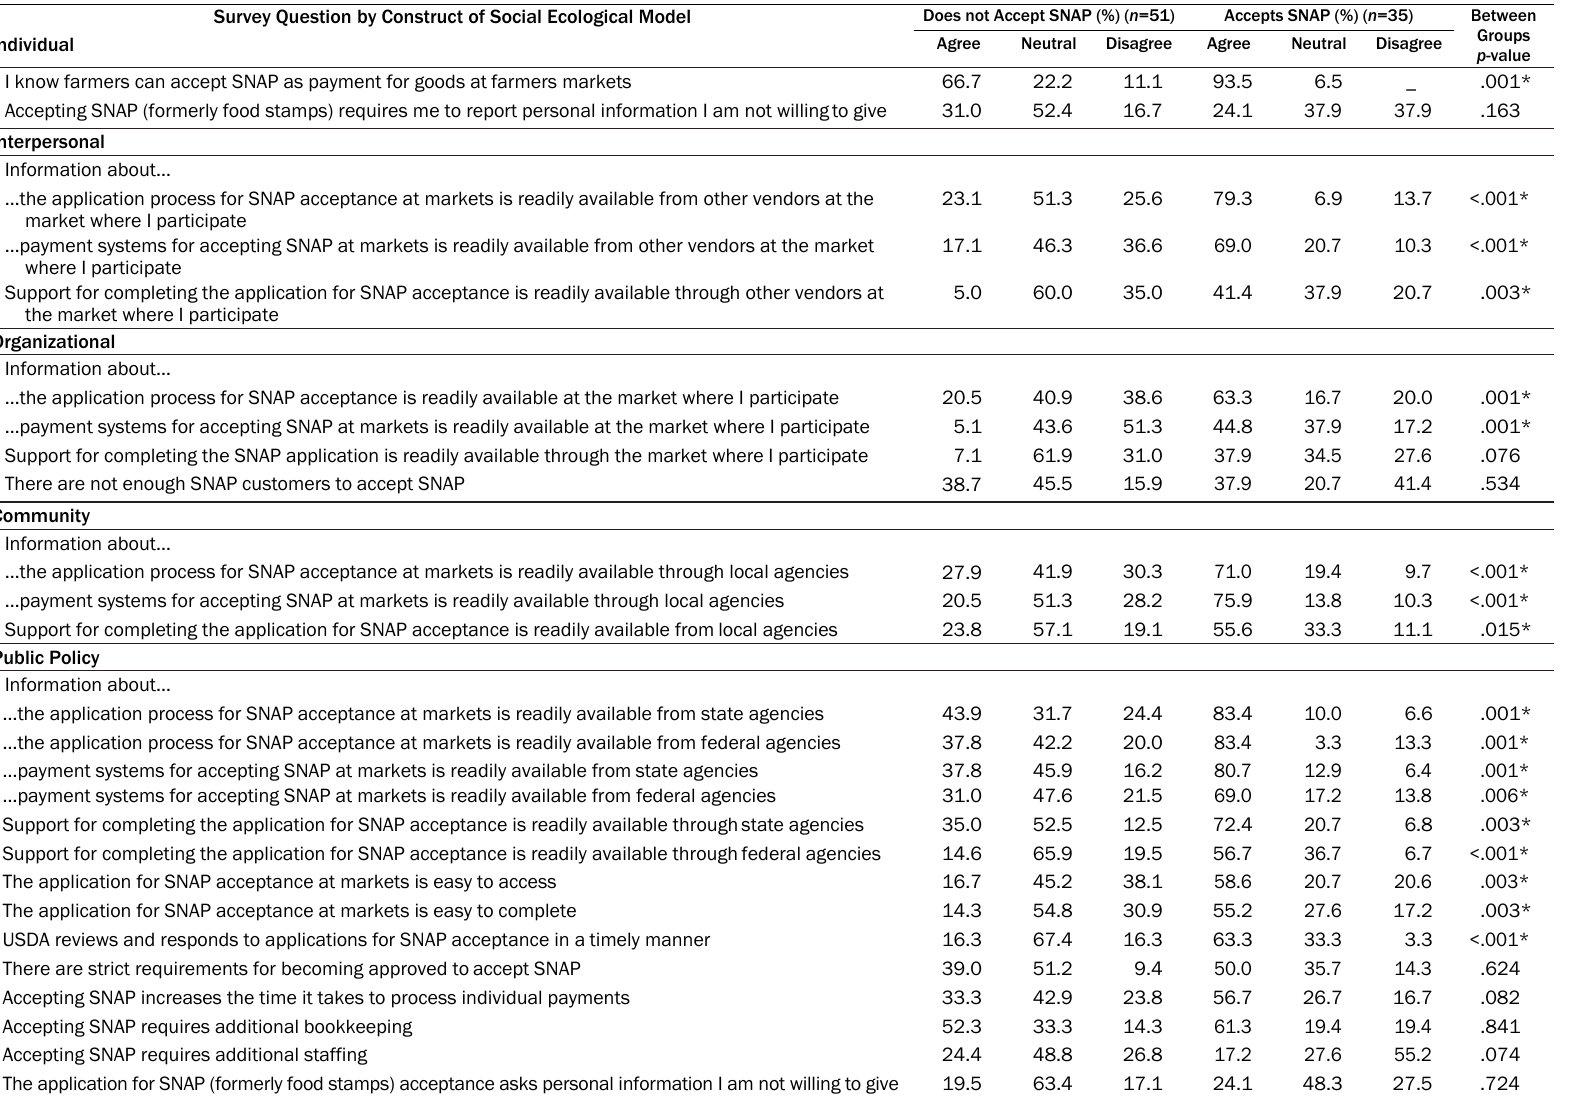
Table 3. Barriers to SNAP Acceptance of Farmers Who Accept SNAP and Those Who Do Not Accept SNAP at Farmers Markets Survey Question by Construct of Social Ecological